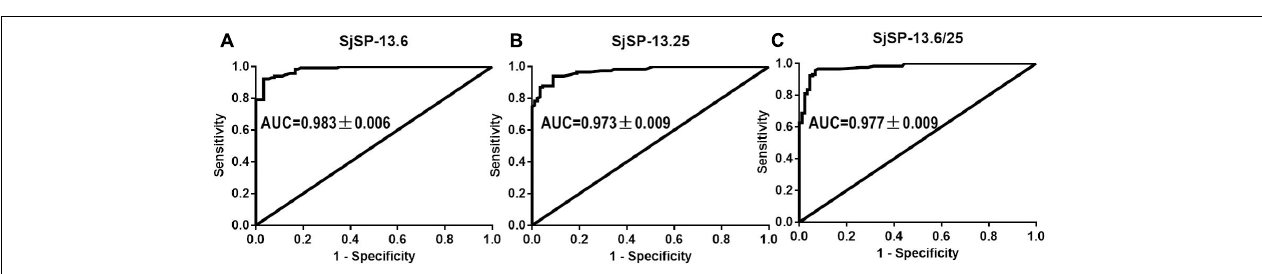
FIGURE 5 | Receiver operating characteristic (ROC) analysis. ROC analysis was performed for SjSP-13.6 (A) , SjSP-13.25 (B) , and SjSP-13.6 combined with SjSP-13.25 (C)